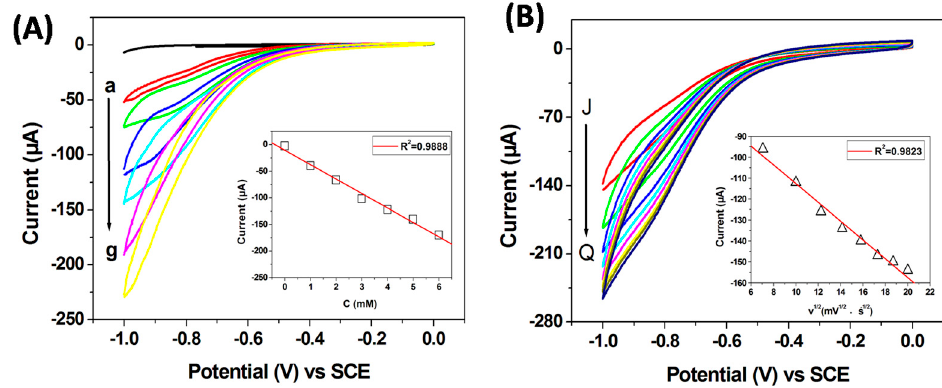
Figure 6. ( A ) CV curves of AuNPs/GCE obtained in N 2 -saturated 0.1 M PBS (pH 7.2) with different H 2 O 2 concentration (from a to g: 0, 1, 2, 3, 4, 5 and 6 mM) at a 50 mV S − 1 scan rate, the inset is the linear fitting program of the reduction peak current (0.9 V) versus the H 2 O 2 concentration; ( B ) CV curves of AuNPs/GCE obtained in N 2 -saturated 0.1 M PBS (pH 7.2) containing 3 mM H 2 O 2 concentration with different scan rate (from J to Q: 50, 100, 150, 200, 250, 300, 350 and 400 mV S − 1 ), the inset is the linear fitting program of the reduction peak current (0.9 V) versus the square root of scan rate.